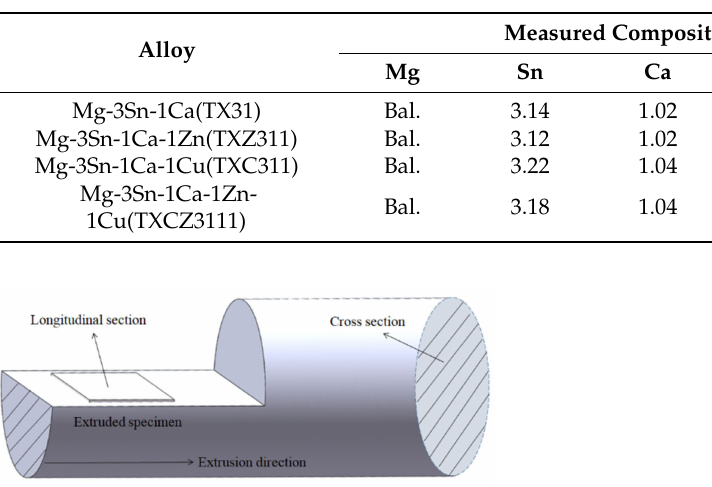
Figure 1. Metallographic sampling location.